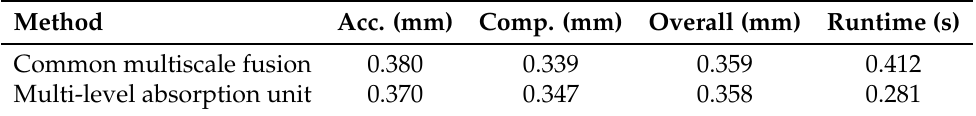
Table 5. Comparison of two multi-scale fusion approaches on DTU [46] dataset ( ↓ ).